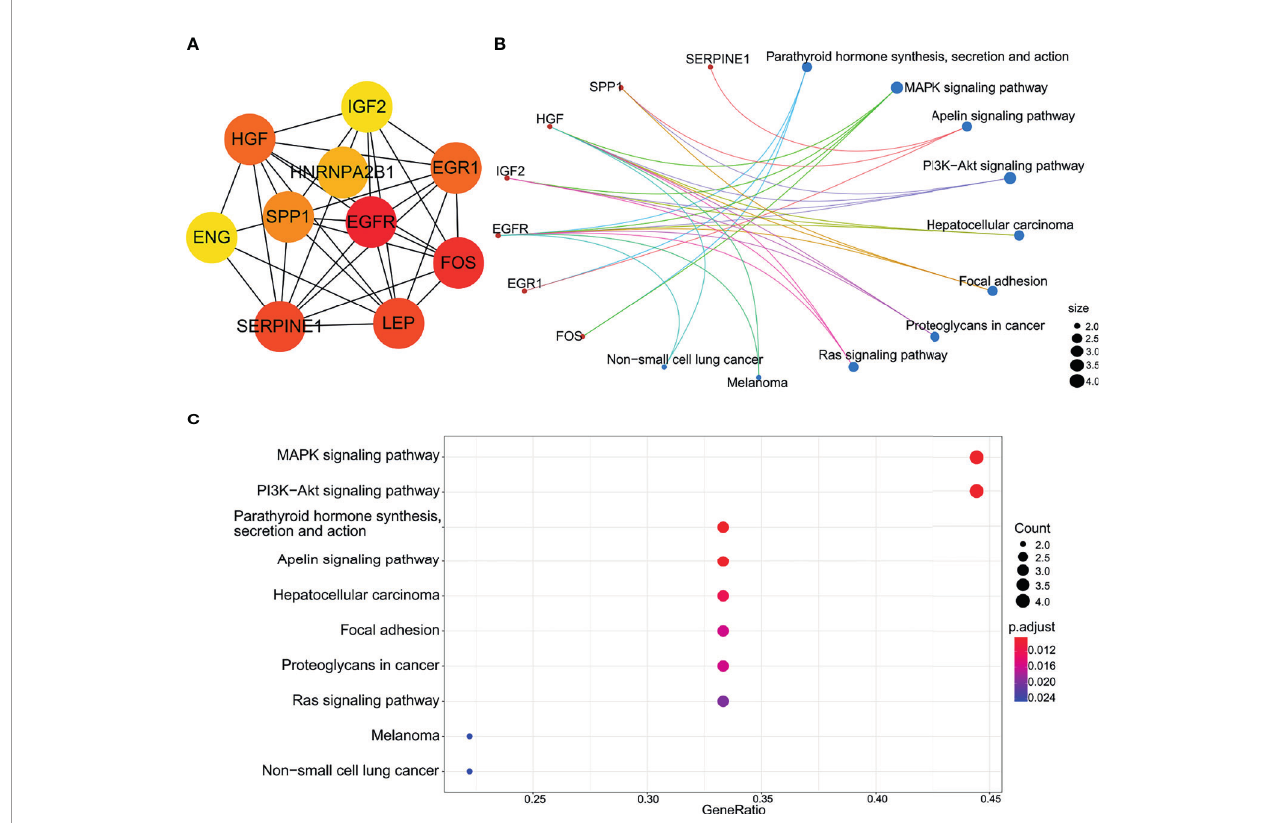
FIGURE 8 | Biological analysis of hub genes. (A) The interaction of 10 hub genes. (B) and (C) the top 10 KEGG enrichment analysis by R